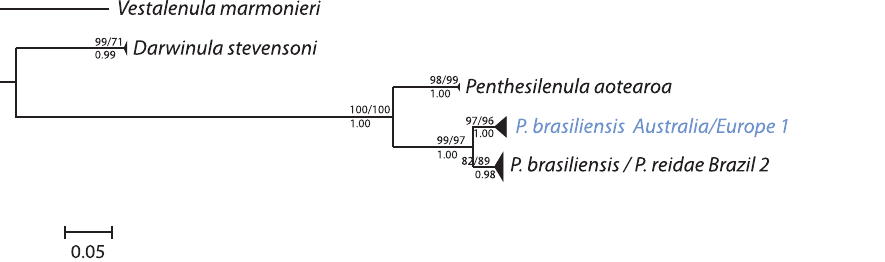
Figure 2. ITS phylogeny of the three darwinulid genera. This phylogeny was obtained by Bayesian Inference. Height of triangles reflects the number of sequences. Triangles or single branches represent EG species, which are indicated by their geographic origin and Arabic numbers. Species names in blue are only recognized by the K/ h method (but not by the GMYC method). Species names in black are recognized by both methods. Numbers above branches are bootstrap values of 1000 replicates for NJ and ML trees ( . 50%), numbers below branches are posterior probabilities of Bayesian Inference.